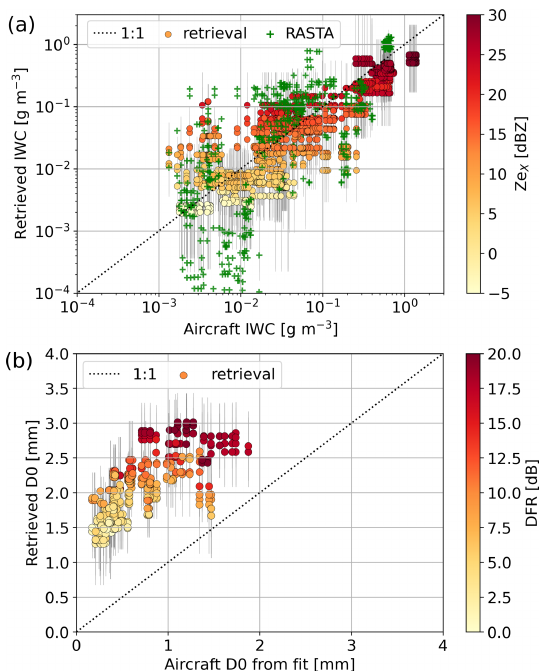
Figure 8. Scatter plots of retrieved vs. aircraft measurement of (a) IWC and (b) size parameter D 0 . Each point corresponds to a time step when the aircraft is within 1km horizontal distance to the radars. Three flights are used (22, 23, and 27 January). Color indi- cates corresponding (a) Ze X and (b) DFR. The black vertical lines indicate the standard deviation of the